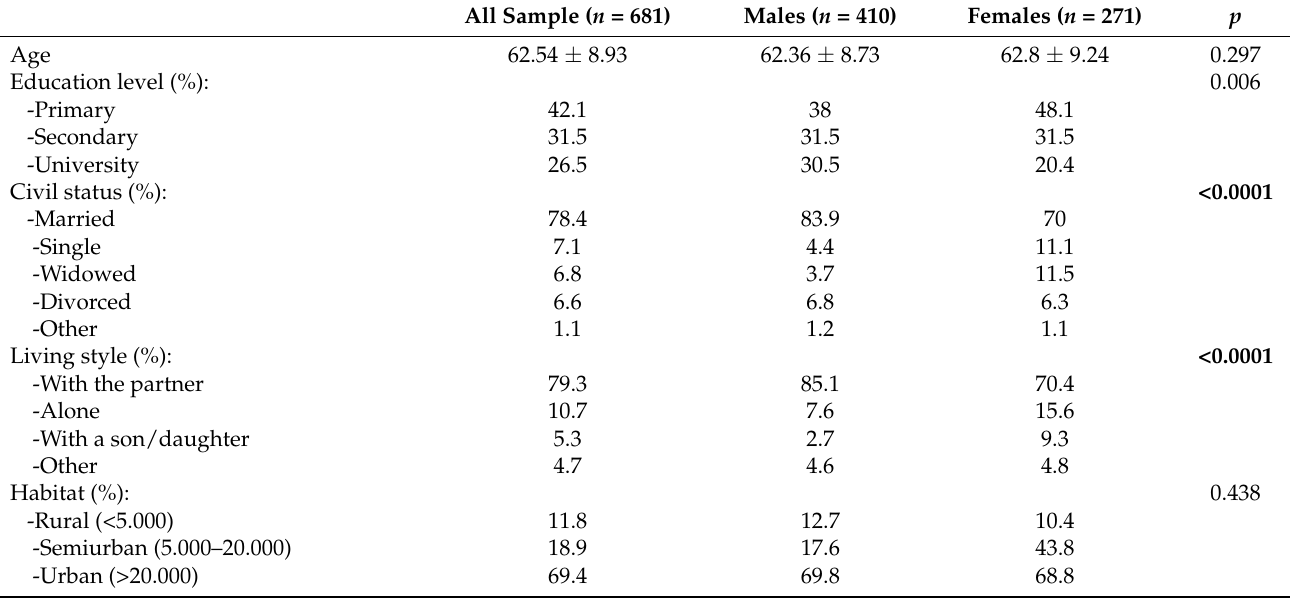
Table 1. Sociodemographic and lifestyle variables and comorbidities in PD patients from the COP- PADIS cohort at baseline (V0) regarding sex ( n =